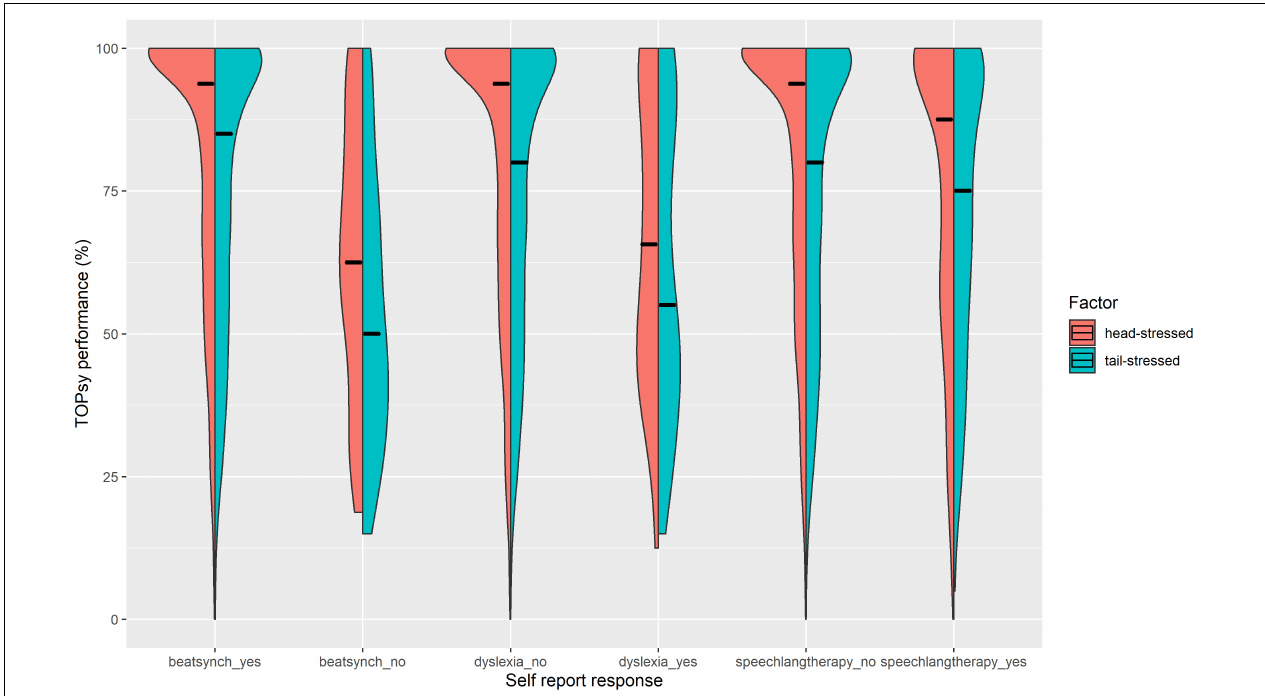
FIGURE 3 | Comparative distributions of lexical stress perception scores on initially stressed items (“head-stressed”; n = 16 items) and non-initially stressed items (“tail-stressed”; n = 12 items), by responses to self-report questions. Median TOPsy scores (%) are marked by horizontal black lines. Within each construct, logistic regressions showed that lexical stress perception significantly predicted higher odds of reporting difficulties with musical rhythm, reading, and speech-language skills. As illustrated, TOPsy performance distributions were noticeably different between yes and no responses, with less of a ceiling effect, and lower medians in individuals reporting difficulty synchronizing with a beat; a dyslexia diagnosis; and a history of speech-language therapy. Lower TOPsy performance most strongly predicts odds of difficulty with beat synchronization (musical rhythm). Differences in median scores and distributions between head-stressed vs. tail-stressed items are relatively stable across all self-report responses and